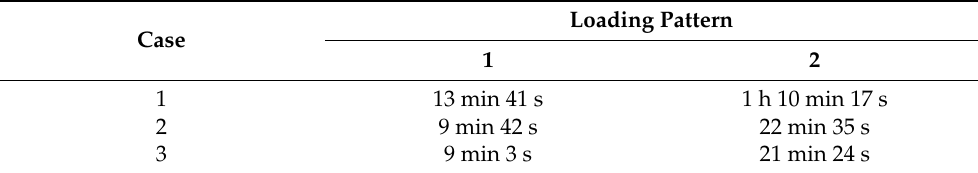
Table 4. Calculation times for the simulation of loading pattern (1) and pattern (2) in three